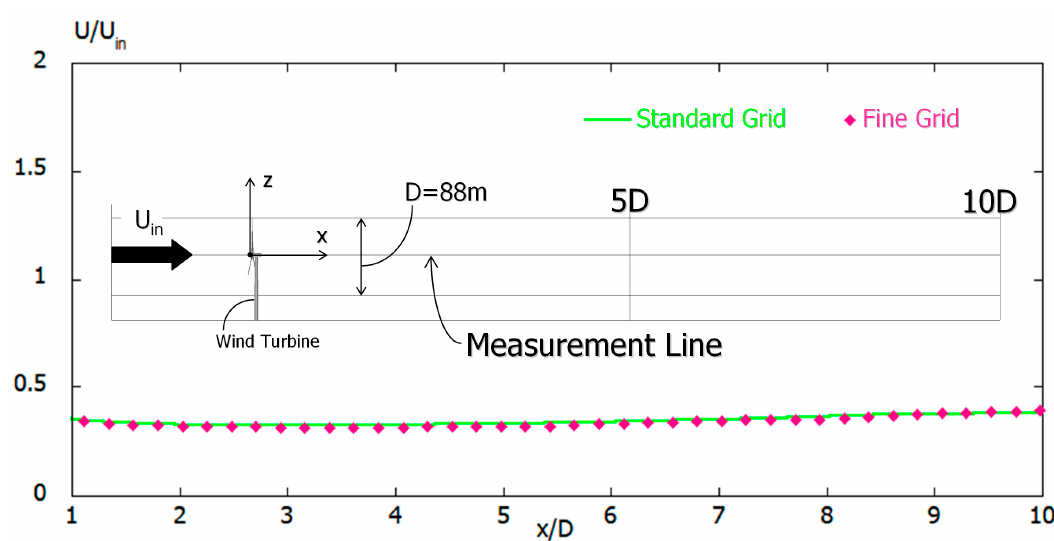
Figure 23. Comparison of time-averaged U-velocity distribution at the hub center of the wind turbine using the CFD PD wake model (C RC = 10.0).